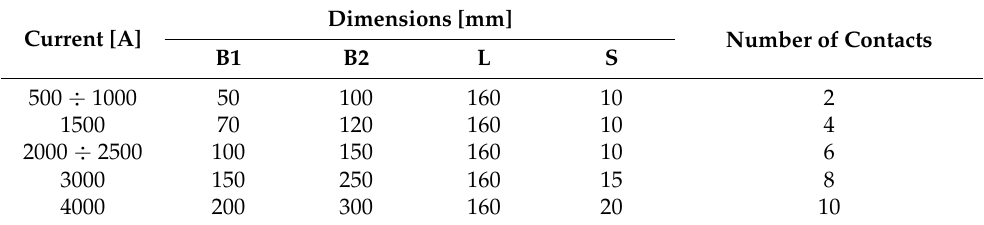
Table 3. Dimensions of individual direct contacts [29].